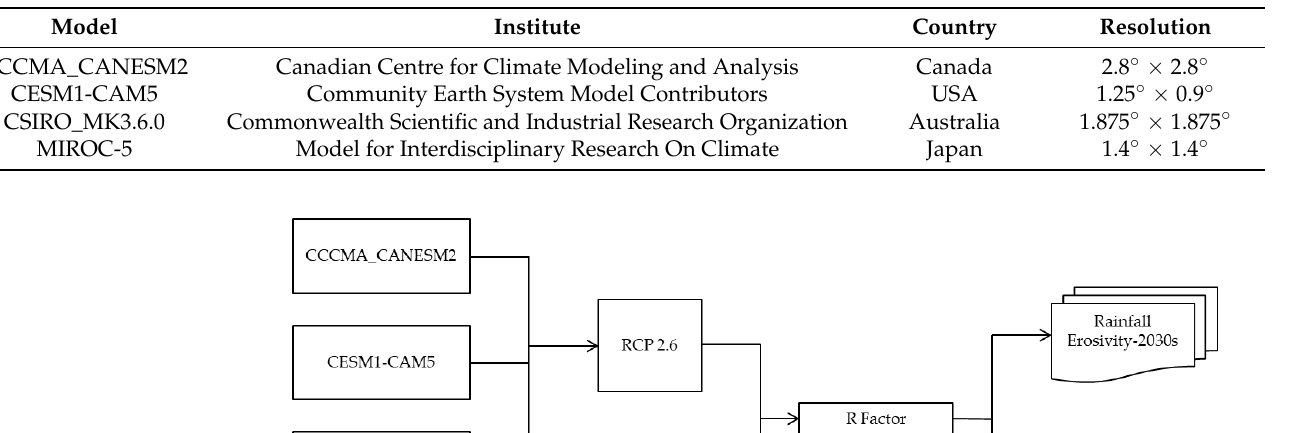
Table 1. Details of the four GCMs applied in this study.